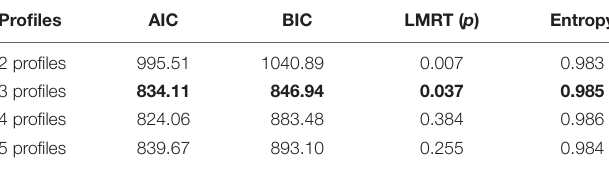
TABLE 1 | Fit statistics for potential LPA models ( N =